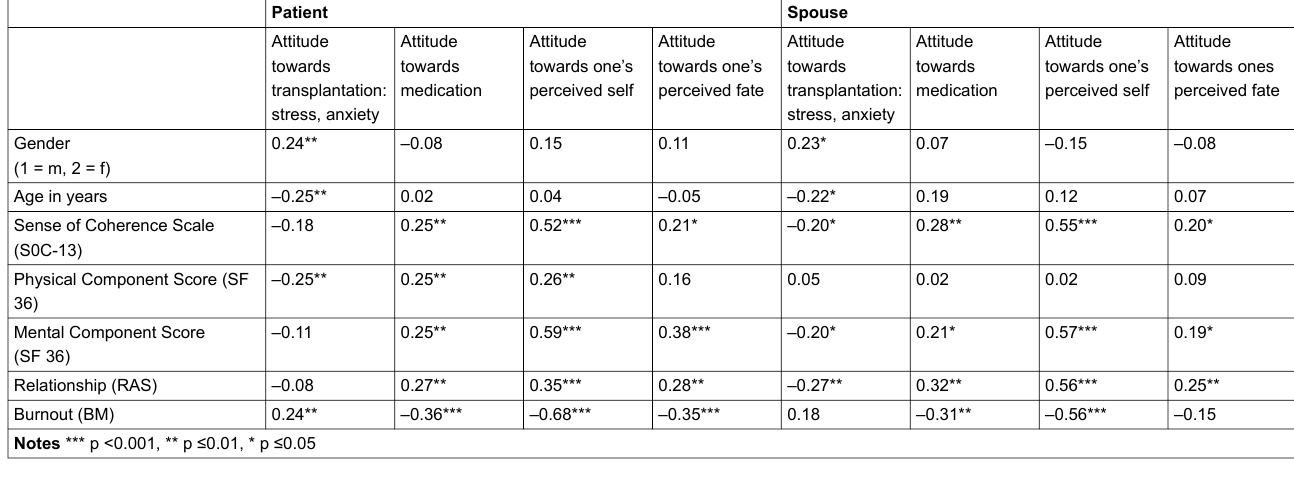
Table 4a: Correlations between the ‘attitudes towards Transplantation’ scales (ATTS) and sociodemographic as well as psychosocial variables (sense of coherence scale, SOC-13; physical component score, SF-36, mental component score, SF 36, relationship assessment scale, RAS, burnout measure scale, BM), n = 121.